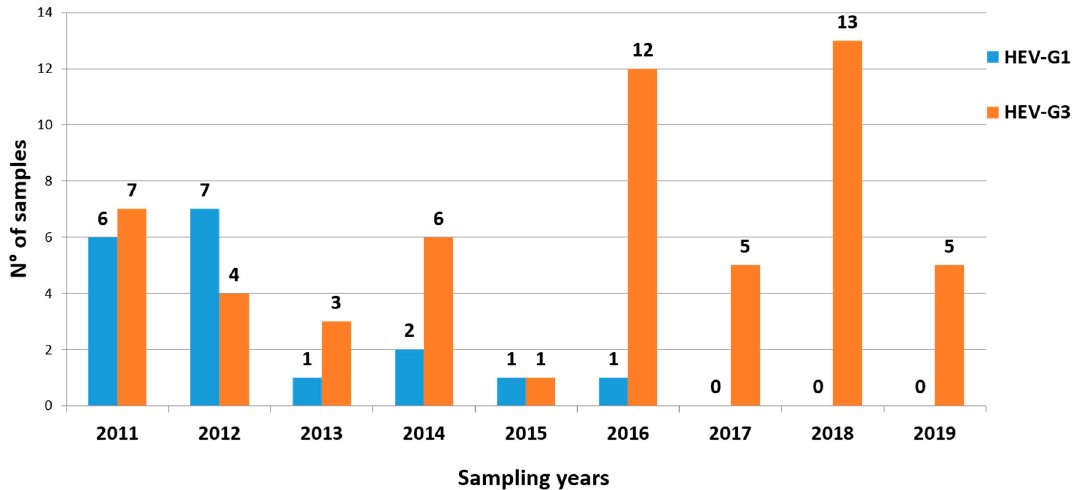
Figure 3. The number of HEV genotype 1 (blue columns) and genotype 3 (orange columns) positive samples detected during the study period (2011–2019).